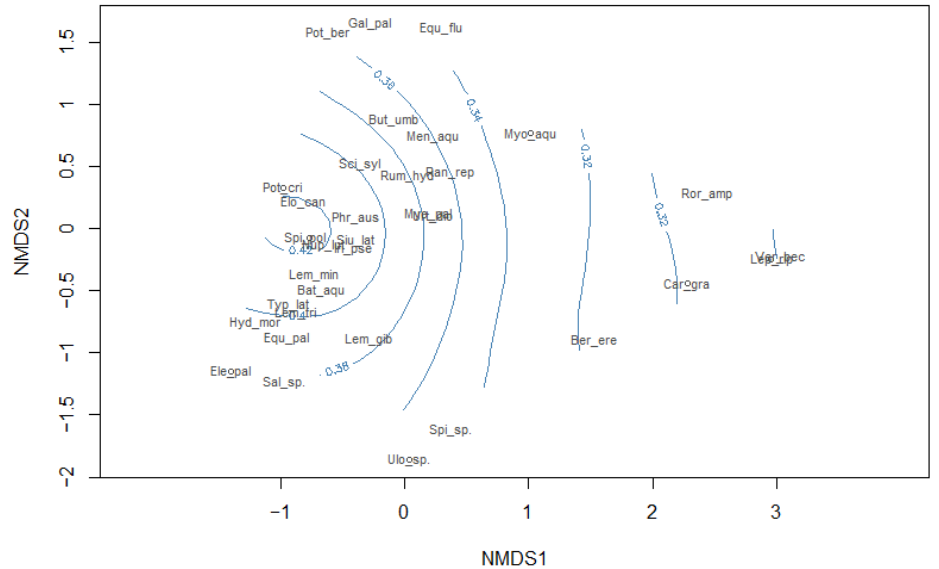
Figure 2. Influence of the water level on biodiversity. WL ranges at 0.32 to 0.44 m.